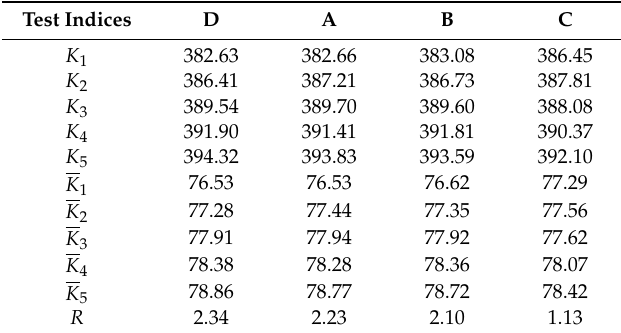
Table 4. Range analysis of η 1